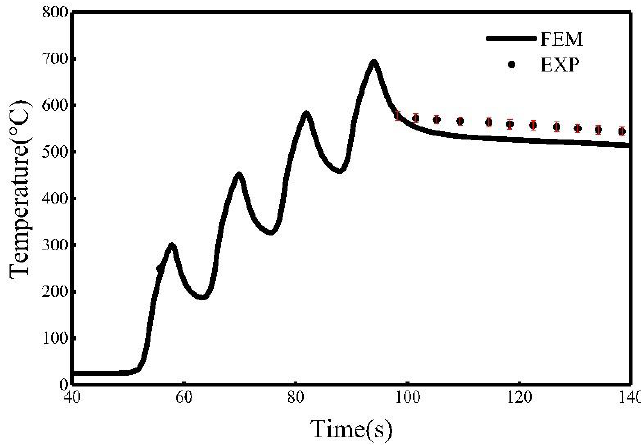
Figure 6. Comparison of temperature history at T 1 . Finite Element Method (FEM), Exponential (EXP).